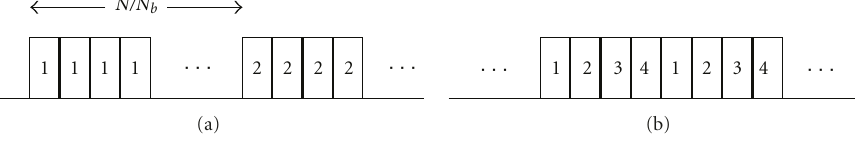
Figure 3: (a) Adjacent subblock partitioning. (b) Interleaved subblock